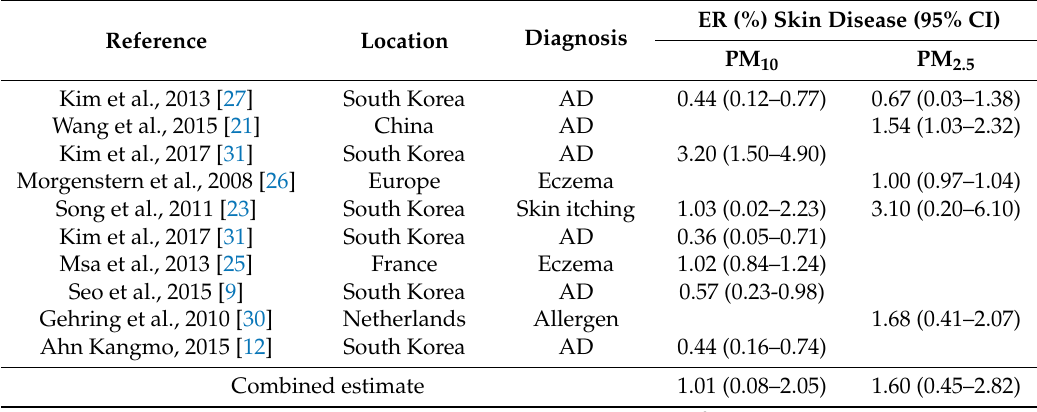
Table 4. ER (%) of skin diseases due to short-term exposure to PM.